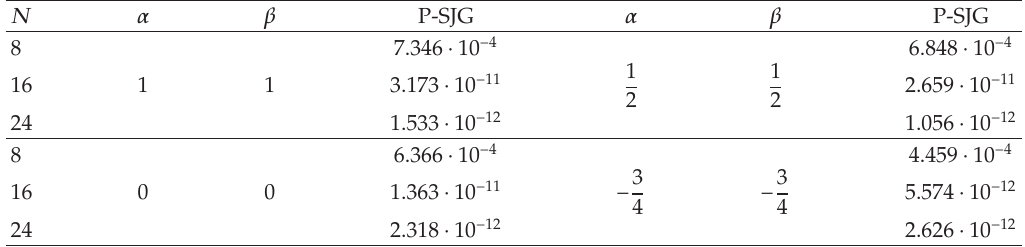
Table 2: Maximum pointwise error using P-SJG method for N (cid:9) 8 , 16 , 24 for Example 6.2. N α β P-SJG